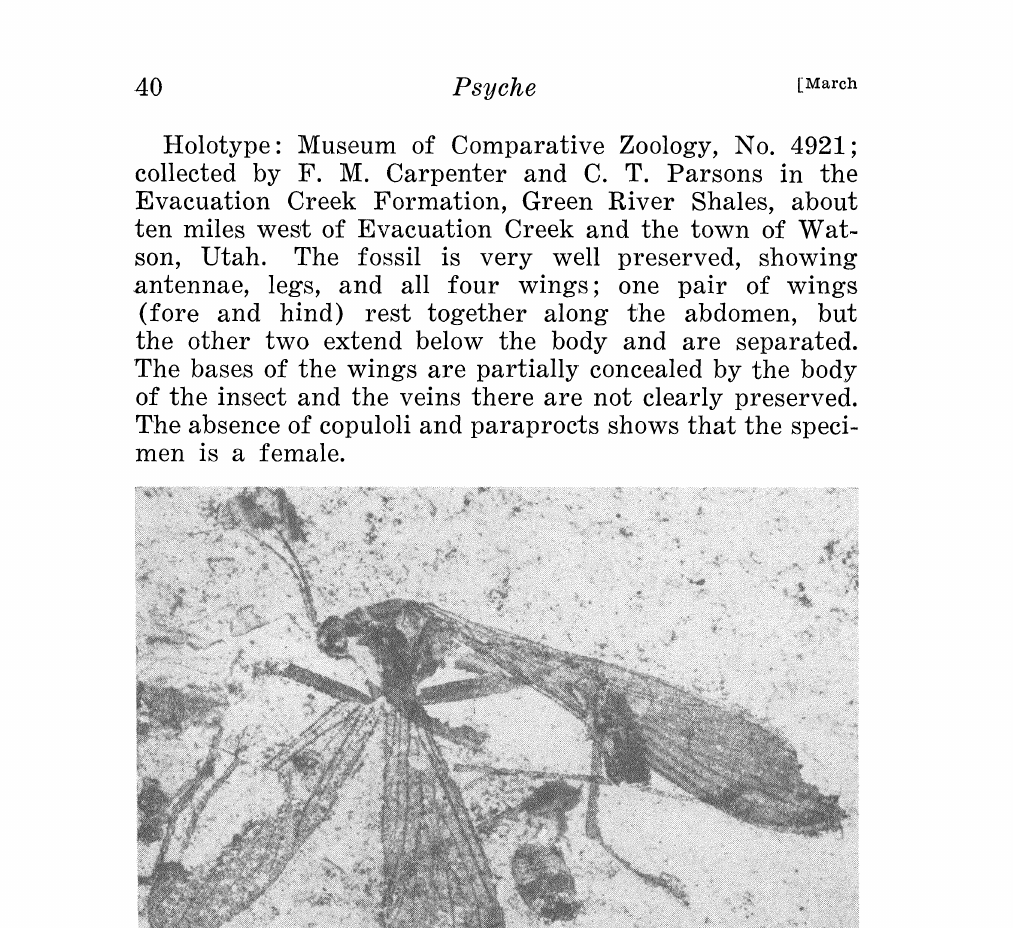
Figure 2. Photograph of Bittacus egestionis, n. sp., from the Eocene of Utah. Length of fore wing, 8